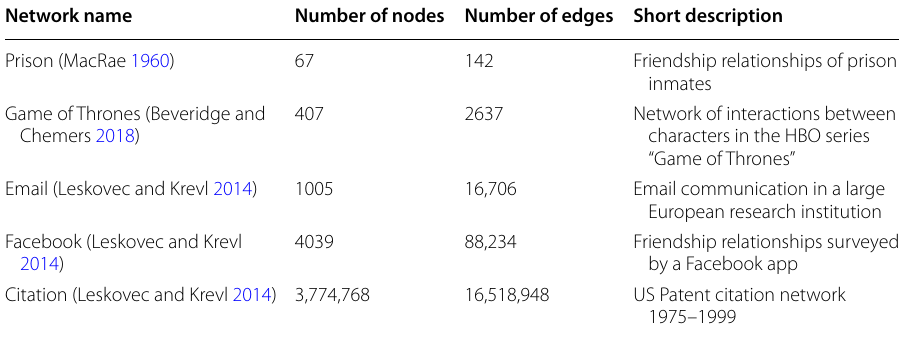
Table 1 Network topologies used in our